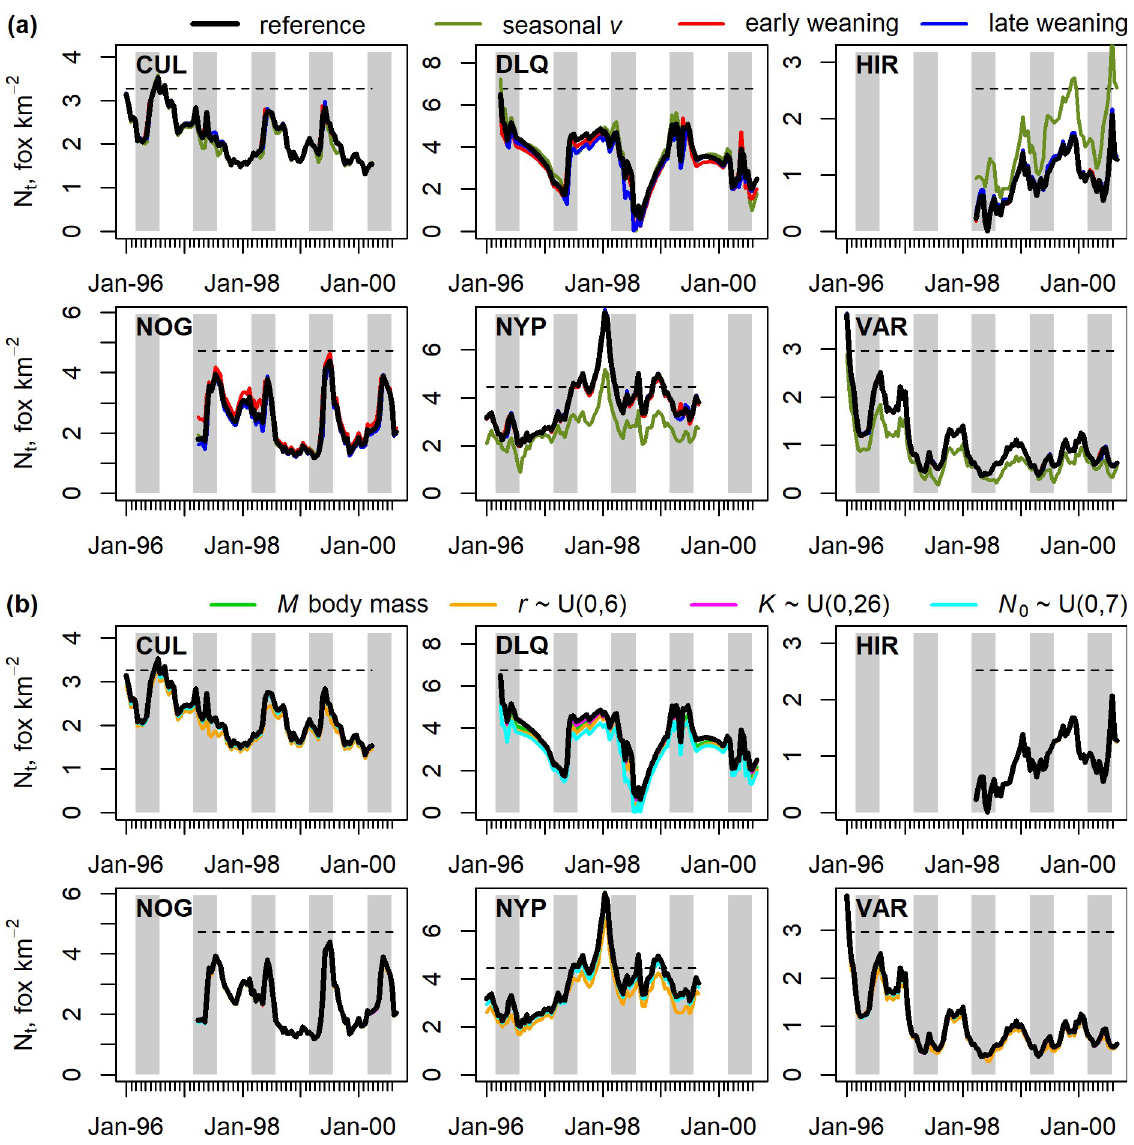
Fig 7. Sensitivity of posterior median fox density on six estates to different structural assumptions and prior distribution specifications. Panel (a) shows sensitivity to structural assumptions about the seasonality of immigration and timing of cub recruitment. Panel (b) shows sensitivity to specification of prior distributions for M , r , K and N 0 . Line colours for each assumption are shown above each set of charts. Reference case (black line) is from the informative prior model. The dashed lines show the posterior median carrying capacity for the reference